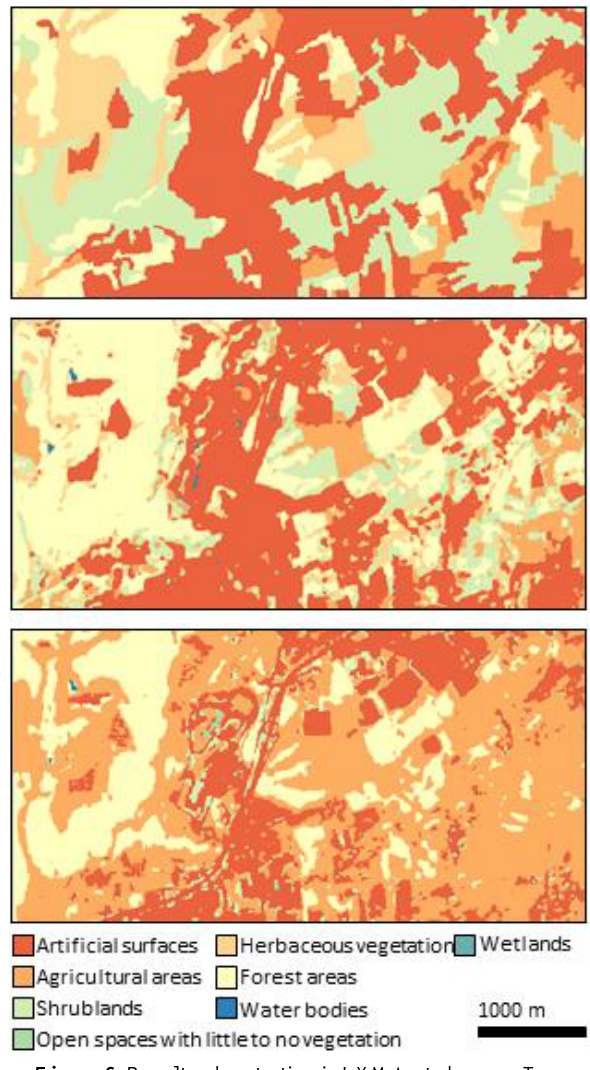
Figure 6. Results when testing in LXMA study area_ Top: COS2018 (considered as ground truth); Middle: model trained with LXMA data; Bottom: model trained with PNSE data. applied to the LXMA